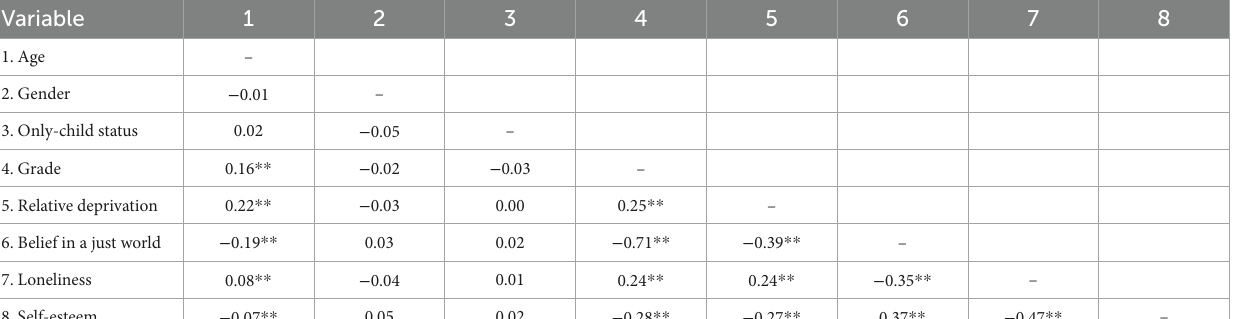
TABLE 2 Correlation statistical